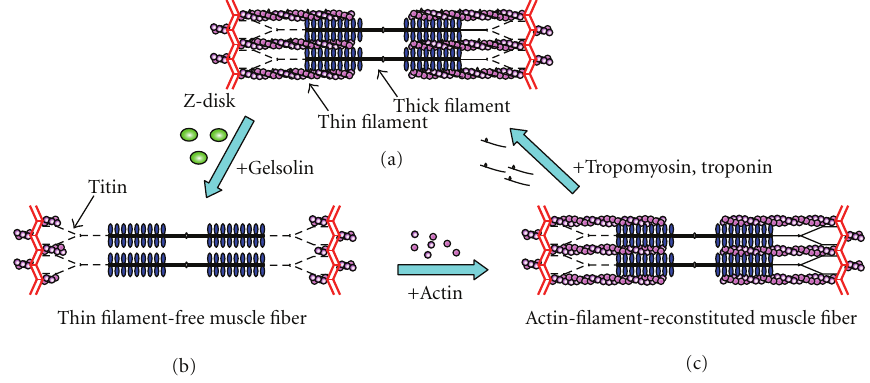
Figure 1: Schematic diagram illustrating the thin filament removal and reconstitution protocol. By applying gelsolin to skinned muscle fibers (a), thin filament free muscle fibers (b) can be obtained. By adding actin monomer to these thin filament free muscle fibers, actin-filament- reconstituted muscle fibers without regulatory proteins (c) can be obtained. Thin filament can be reconstituted by adding regulatory proteins to these actin-filament-reconstituted muscle fibers.